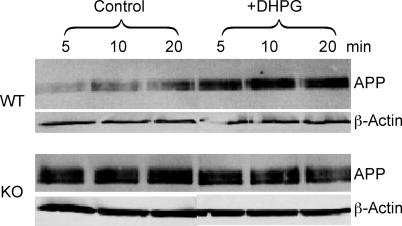
Differential Regulation of APP Levels in WT and KO SNsWestern blots of WT (top panel) and KO (bottom panel) SN treated with or without DHPG (5, 10, and 20 min) and hybridized with anti-APP and anti–β-actin antibodies. The data are representative of three experiments, and quantitation with ImageQuant software demonstrates a 1.6–1.8-fold increase in APP between untreated and DHPG-stimulated WT SNs at all of the times tested.